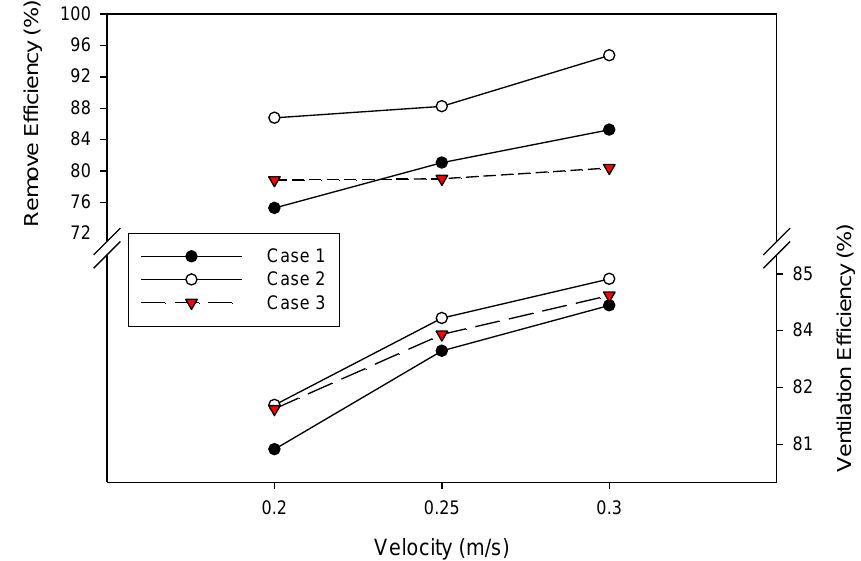
Figure 10. Removal and ventilation efficiency of the biotech cleanroom.